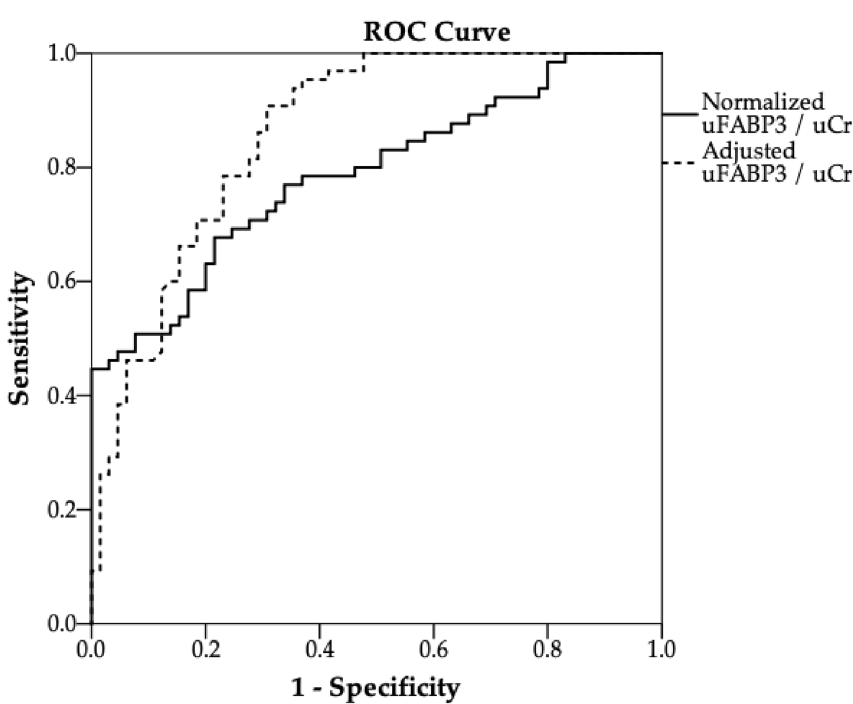
Figure 2. Receiver operating characteristic (ROC) curves of uFABP3/uCr for distinguishing patients with peripheral arterial disease (PAD, n = 65) from patients without PAD (non-PAD, n = 65) in an unadjusted model (solid line) and an adjusted model (dashed line). The area under the curve (AUC) and the 95% confidence intervals for uFABP3/uCr improved from 0.79 (95%: 0.71–0.87) to 0.86 (95%: 0.80–0.92) after adjusting for eGFR, age, hypercholesteremia, smoking and